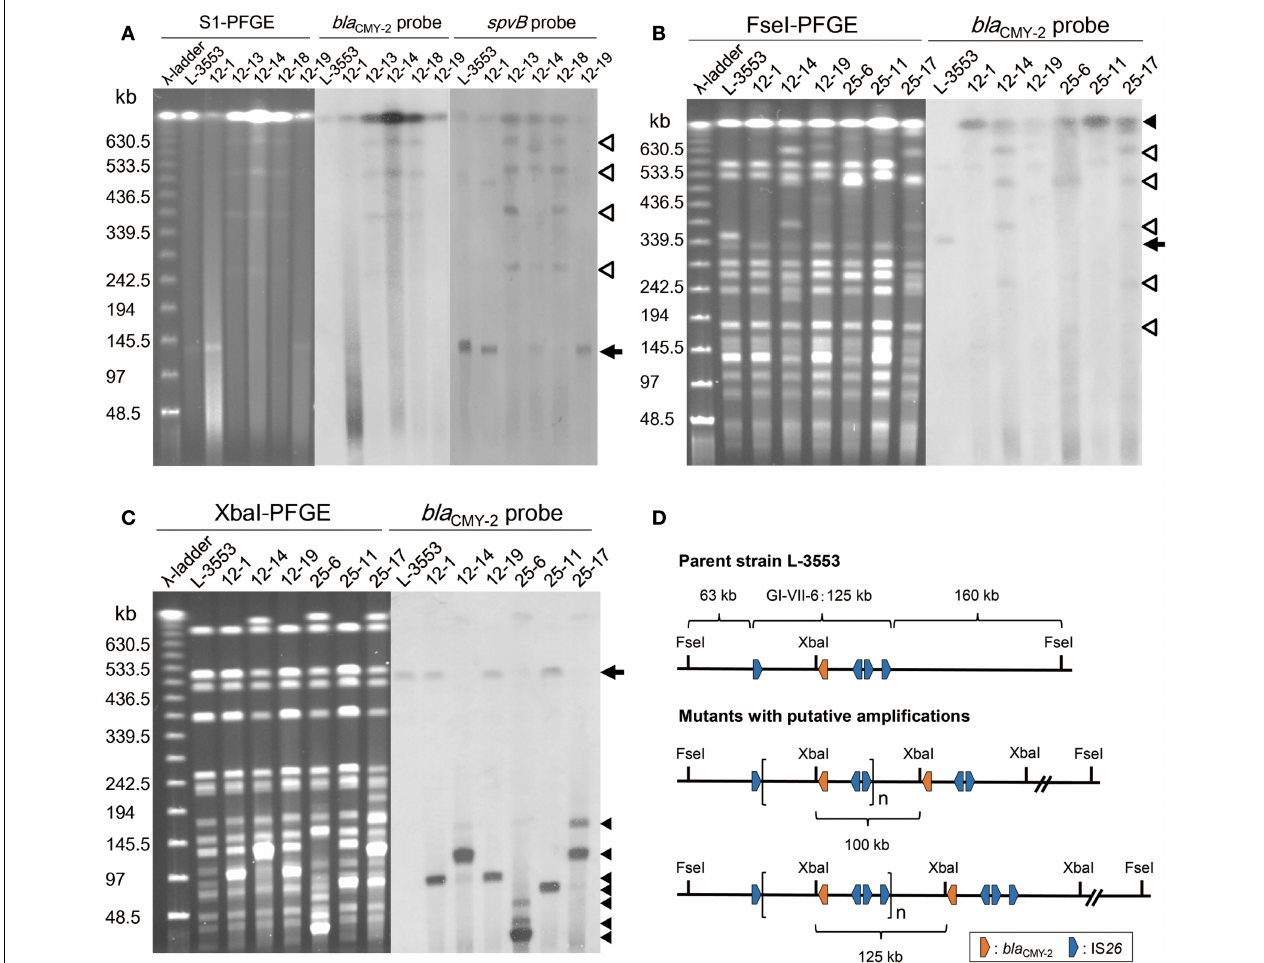
FIGURE 4 | PFGE–Southern hybridization images demonstrating bla CMY − 2 and spvB locations in S . Typhimurium strains. (A) PFGE separation of S1 nuclease-digested genomic DNA from the selected strains followed by Southern hybridization with probes specific to bla CMY − 2 and spvB . An arrow indicates the position of the endogenous 133-kb plasmid, in which the spvB signal was detected. Open triangles indicate the positions of enlarged plasmids, in which both bla CMY − 2 and spvB signals were detected. Both signals were observed in multiple plasmid bands in strains 12-13, 12-14, and 12-18. (B) PFGE separation of FseI-digested genomic DNA from the selected strains followed by Southern hybridization with a bla CMY − 2 probe. An arrow indicates the original position of the restricted fragment (350kb) in which the chromosomal bla CMY − 2 signal was detected. In the selected mutants, this fragment was not present and the bla CMY − 2 signal was